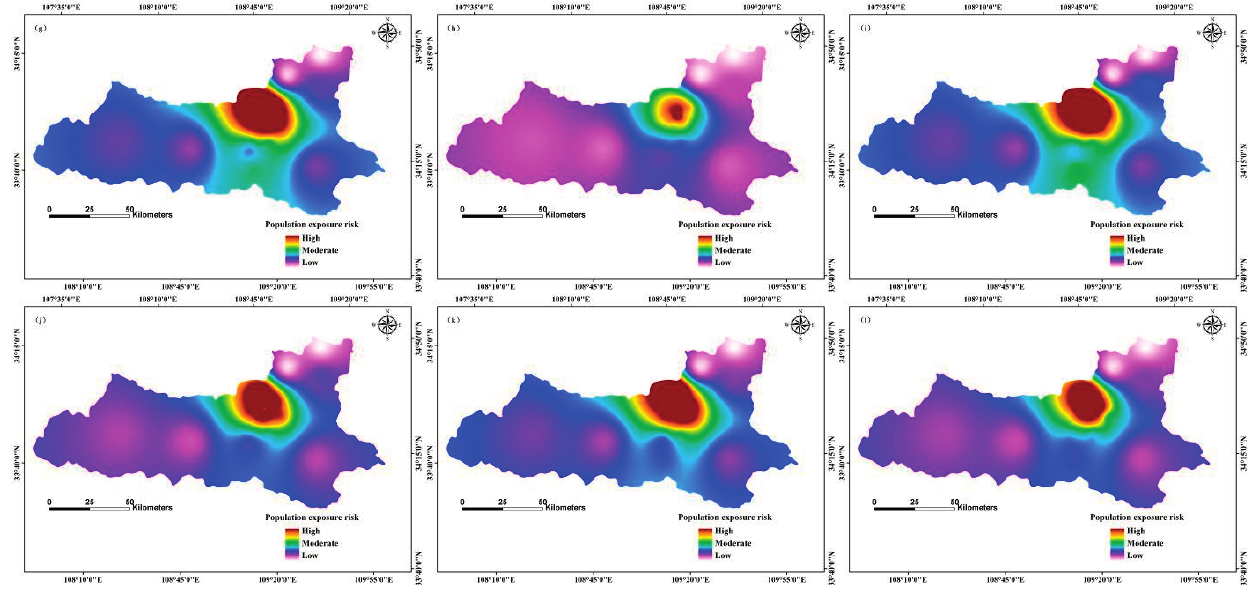
Figure 6. Risk of population exposure to PM2.5 in 2013 in Xi’an, China by month: ( a ) January; ( b ) February; ( c ) March; ( d ) April; ( e ) May; ( f ) June; ( g ) July; ( h ) August; ( i ) September; ( j ) October; ( k ) November; ( l )